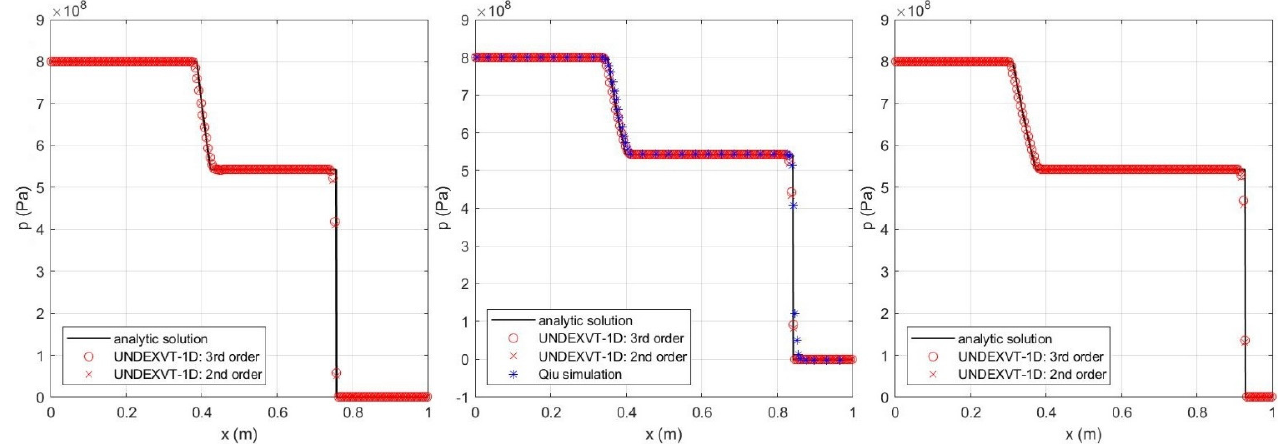
Figure 15. Pressures at 1.2 × 10 (cid:2879)(cid:2872) 𝑠 , 1.6 × 10 (cid:2879)(cid:2872) 𝑠 and 2.0 × 10 (cid:2879)(cid:2872) 𝑠 (from left to right ) .